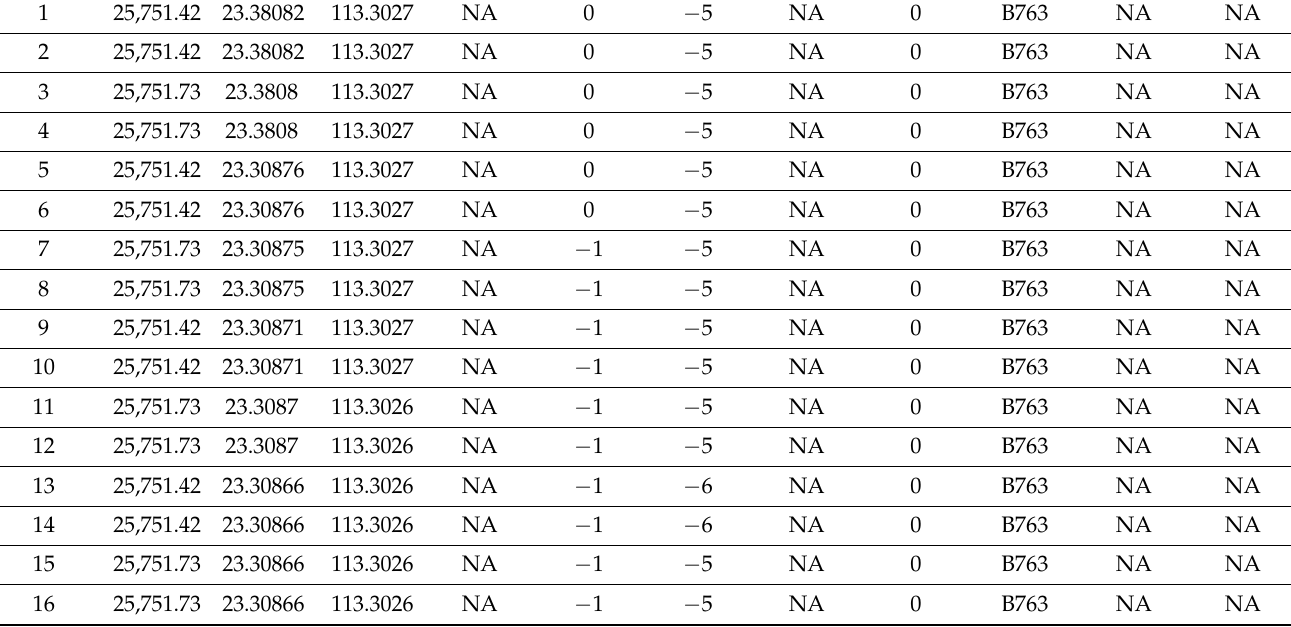
Table 2. Trajectory data.